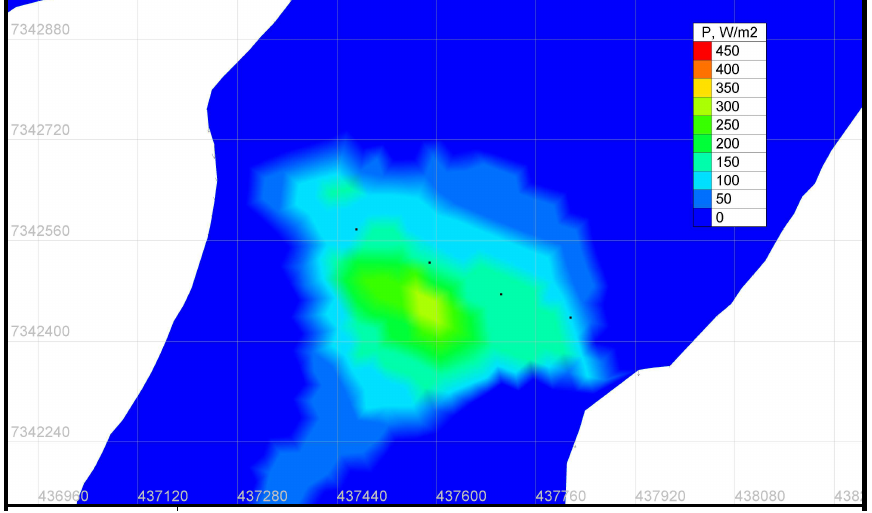
Figure 13. Example of the resource distribution ( P time as Figure 10a). Black dots are the four selected points chosen for quantifying the effect of different cross-sectional velocities (Figure 12). The incoming tidal resource is higher in the centre of the